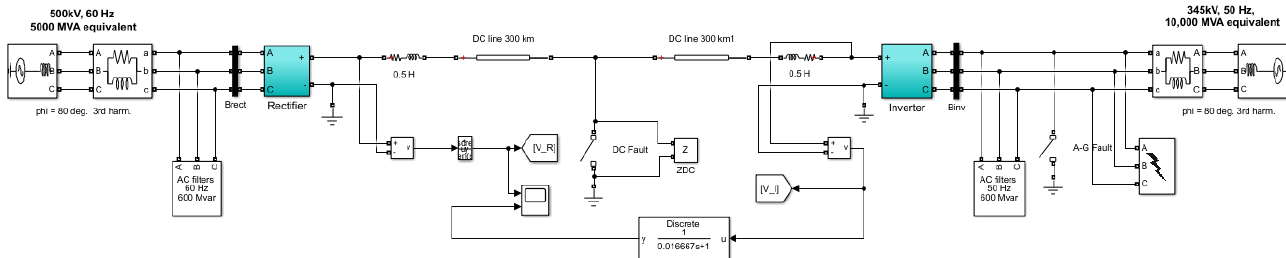
Figure 1 . HVDC system fault classes ( A ) a-g, ( B ) b-g, ( C ) c-g, ( D ) ab-g, ( E ) bc-g, ( F ) ac-g, ( G ) a-b, ( H ) b-c, ( I ) a-c, ( J ) a-b-c-g, ( K ) DC fault [34].